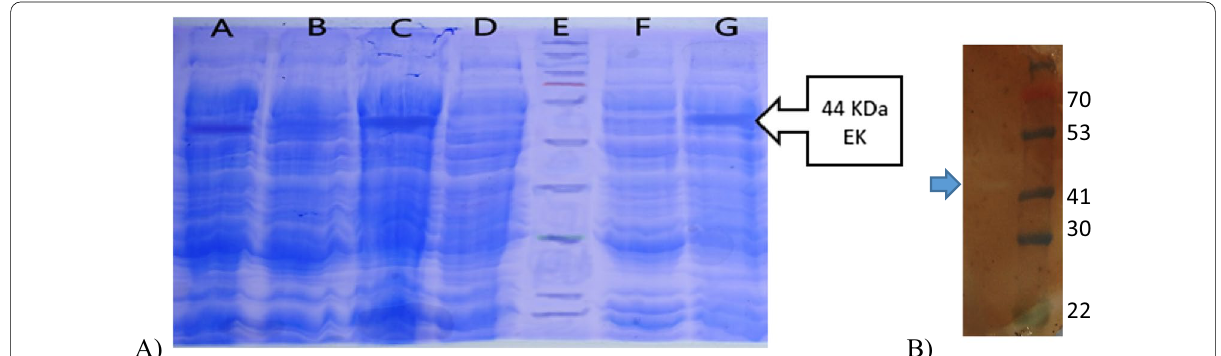
Fig. 1 A Result of electrophoresis of total protein extracted from bacteria on SDS-PAGE gel. In this figure A D C − SHuffleT7, E =